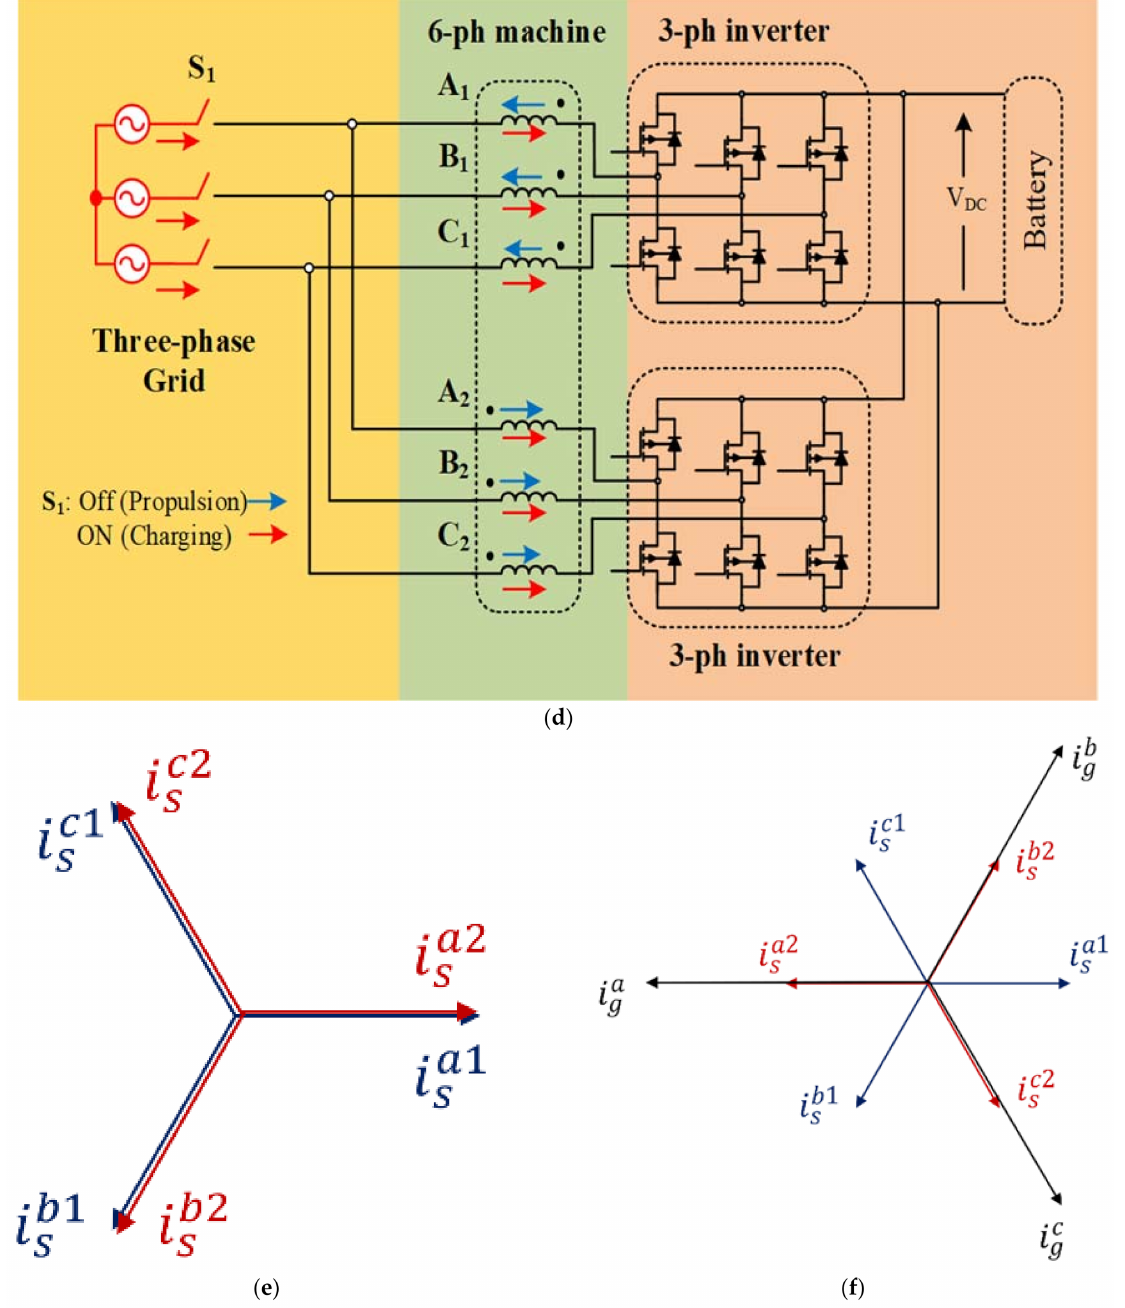
Figure 1. Typical six-phase integrated battery charger schematic and phasor diagrams. ( a ) Asymmetrical six-phase configuration, ( b ) phasor diagram under propulsion, and ( c ) phasor diagram under charging. ( d ) Dual three-phase configuration, ( e ) phasor diagram under propulsion, and ( f ) phasor diagram under